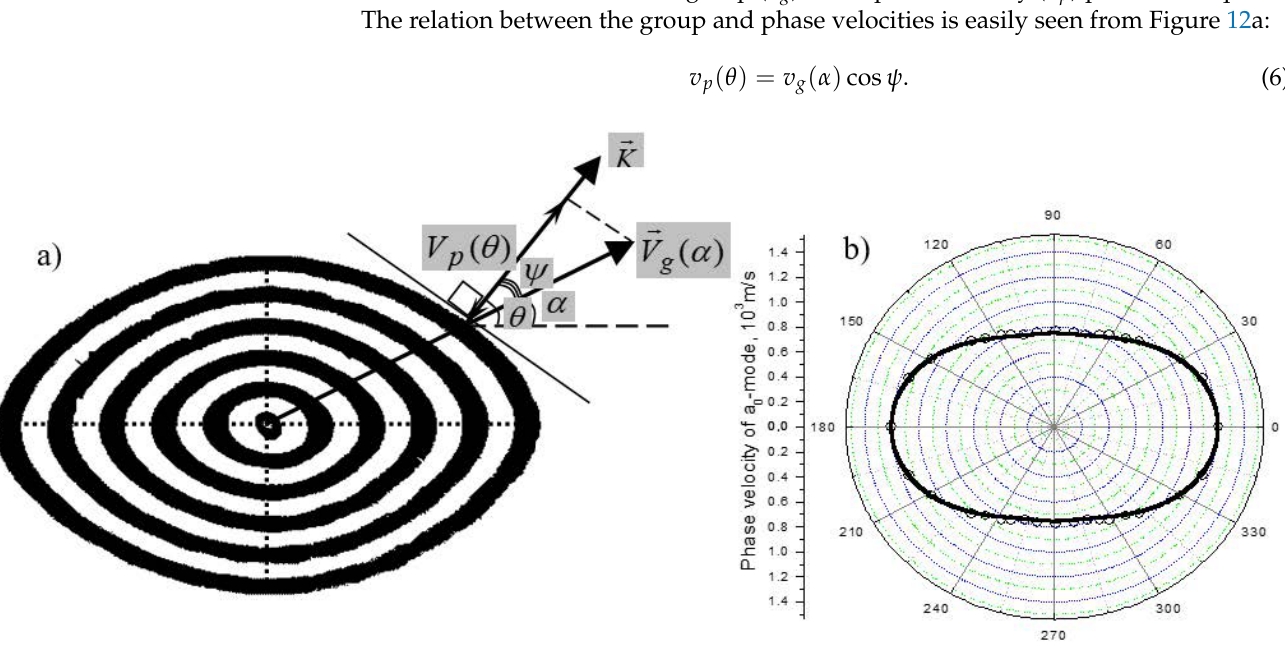
Figure 12. Relation between group and phase velocities for plate waves. The group velocity pattern ( a ) is measured by WIM in CFRP at ( f · D ) = 175. Phase velocity pattern converted from the WIM data ( b , circles); calculations for UD-CFRP at ( f · D ) = 175 ( b , solid